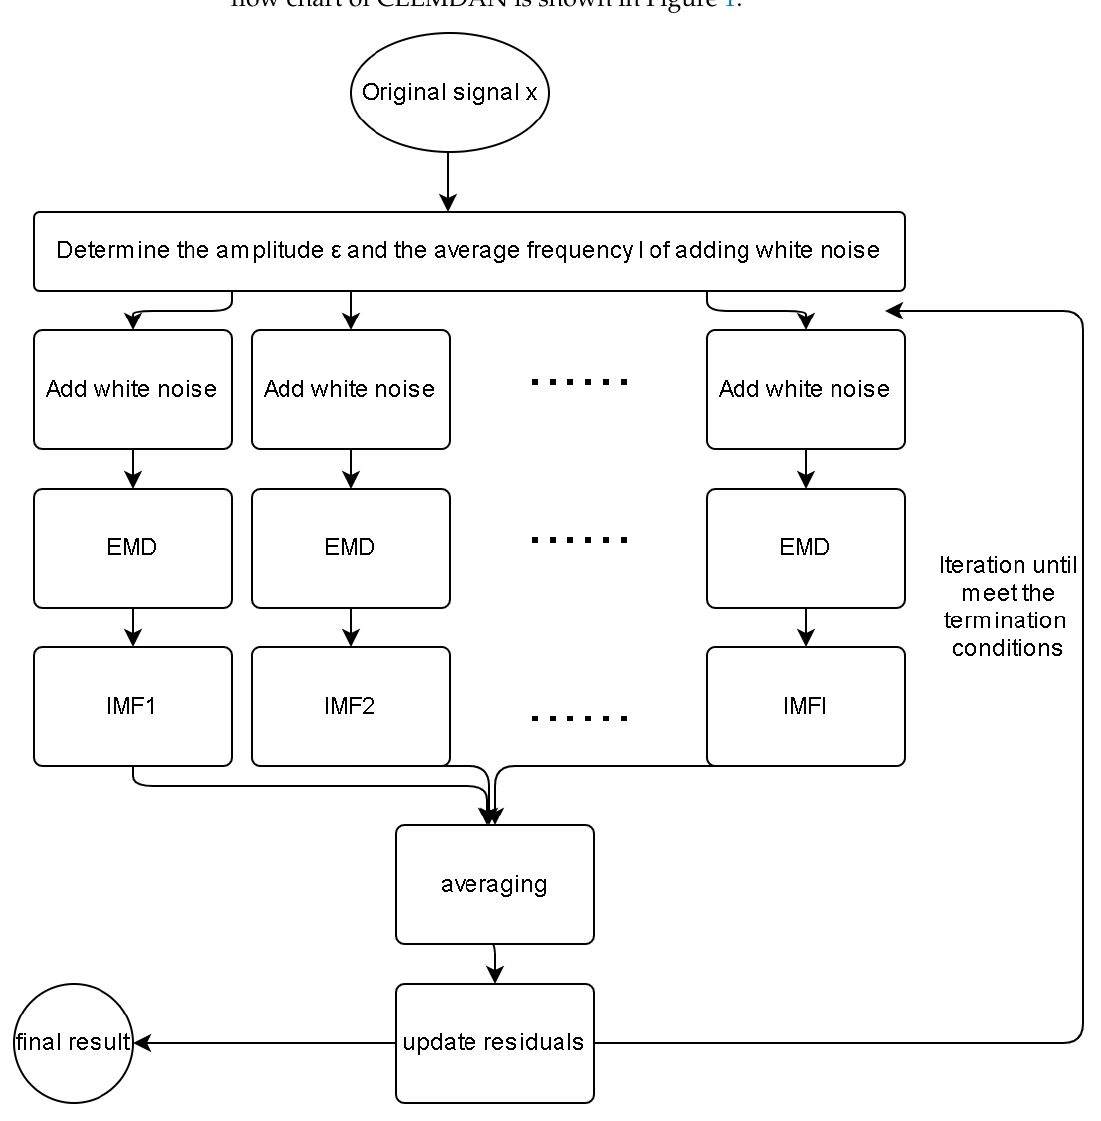
Figure 1. The flow chart of